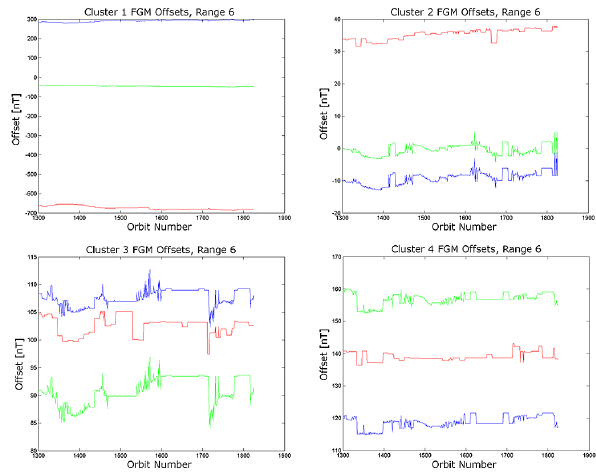
Figure 8. Range 6 spin-axis ( O 1 , red) and spin-plane ( O 2 and O 3 , blue and green) offsets in nanoteslas for orbits 1300–1825 (Decem- ber 2008–February 2012).